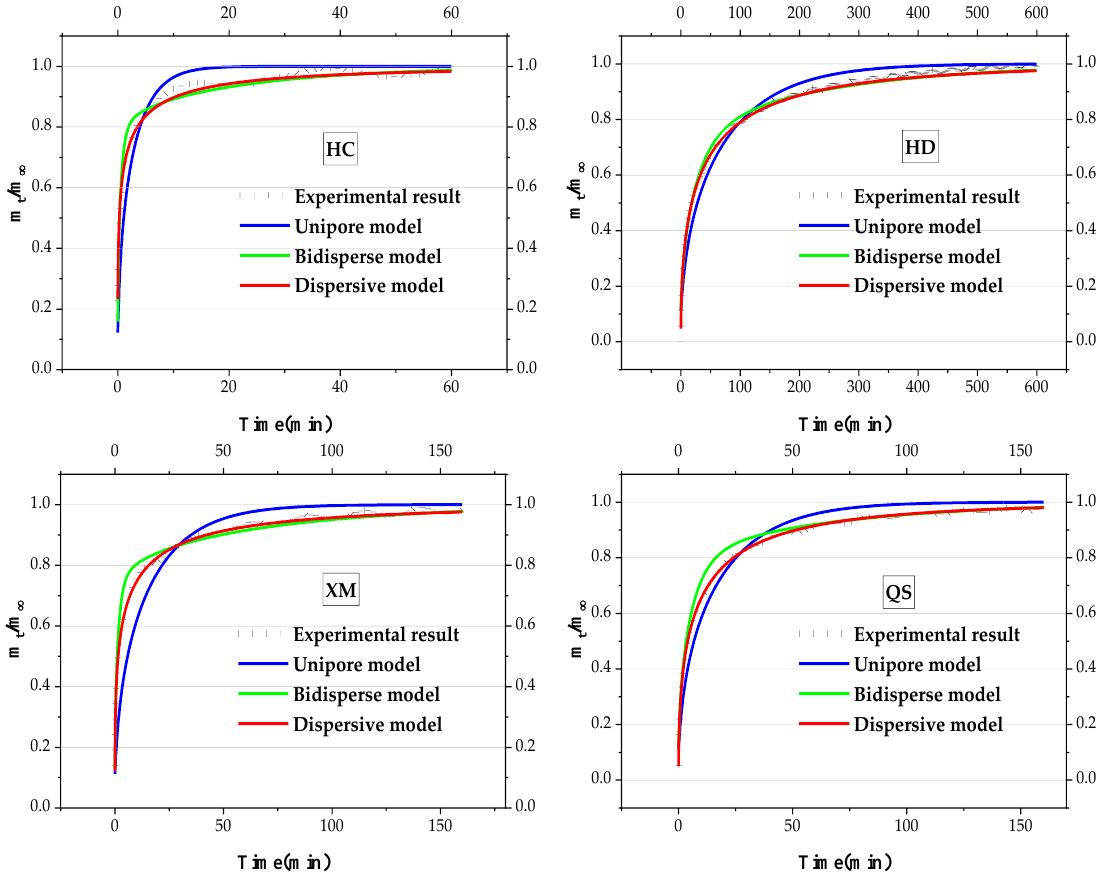
Figure 5. Experimental results and fitting diffusion lines of coal samples.